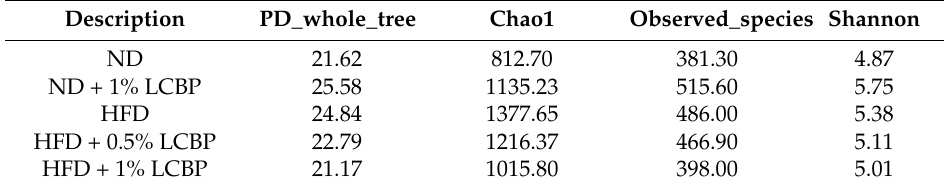
Table 1. The effect of LCBP on the diversity of gut microbiota.